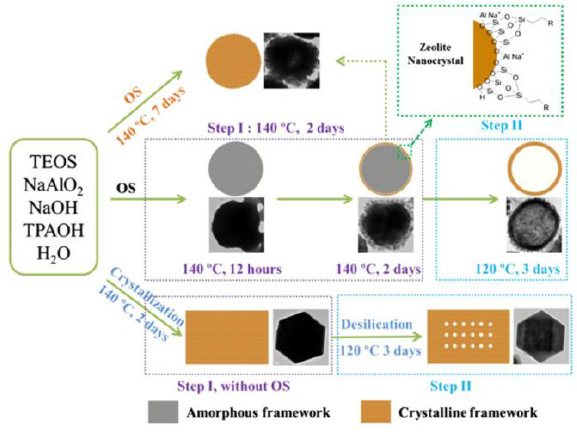
Figure 1. Schematic illustration of the structural changes of hollow zeolite spheres during crystallization procedure [31]. Copyright Elsevier, 2013.